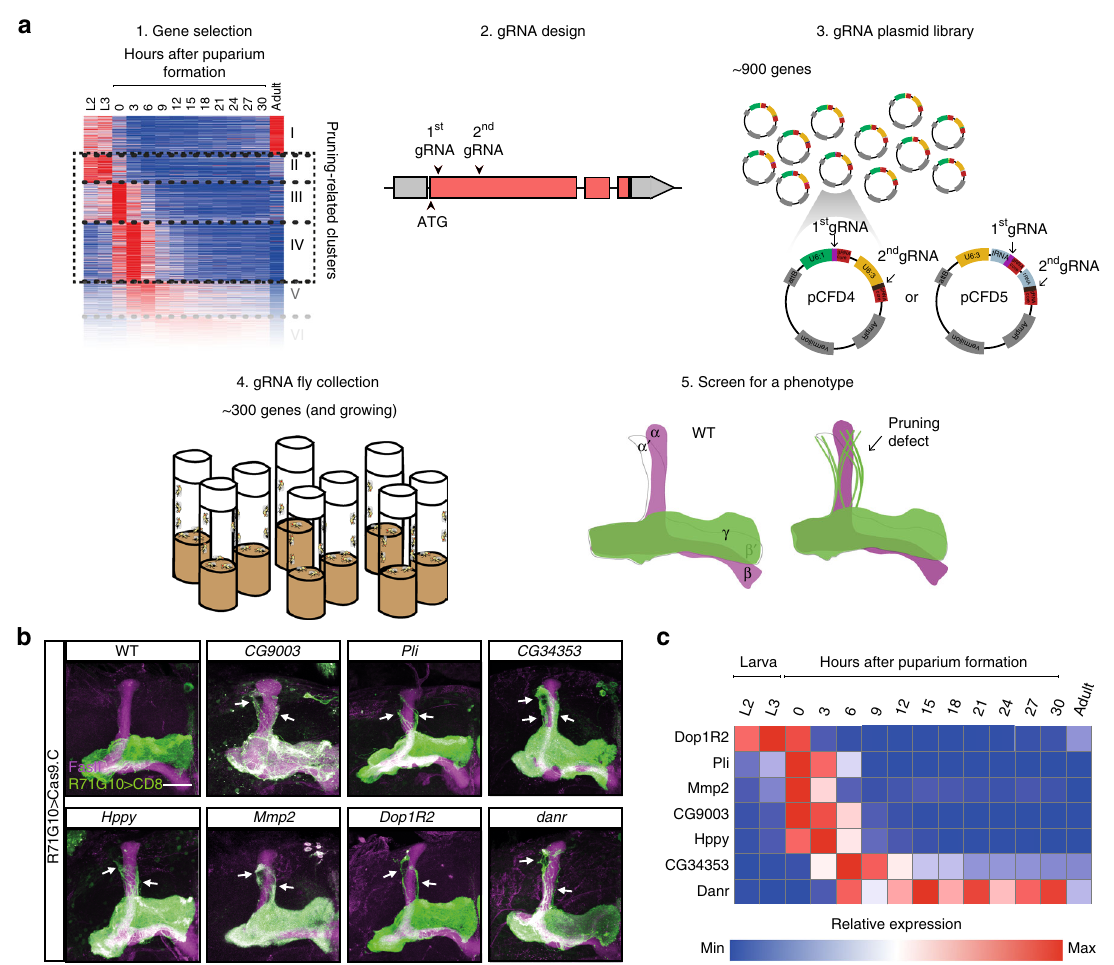
Fig. 3 tsCRISPR screen reveals unknown neuronal remodeling genes. a Outline of the screen, including the generation of the gRNA fl y collection (items 1,5 adapted from ref. 25 ). b Confocal Z-projections of adult MBs expressing gRNAs targeting the indicated genes (in pCFD4), as well as UAS-Cas9.C and CD8 driven by R71G10-GAL4 . White arrows highlight unpruned γ axons. c Heat-map displaying the expression pro fi les of the genes in b within MB γ neurons throughout development 25 . Red and blue represent high- and low-relative expression of each gene during development, respectively. Source data are provided as a Source Data fi